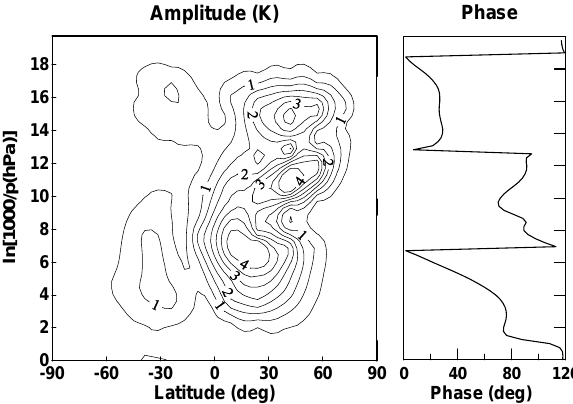
Fig. 8. As in Fig. 4, but for the 2-day wave and only for 1 July. The phase is shown at 45 ◦